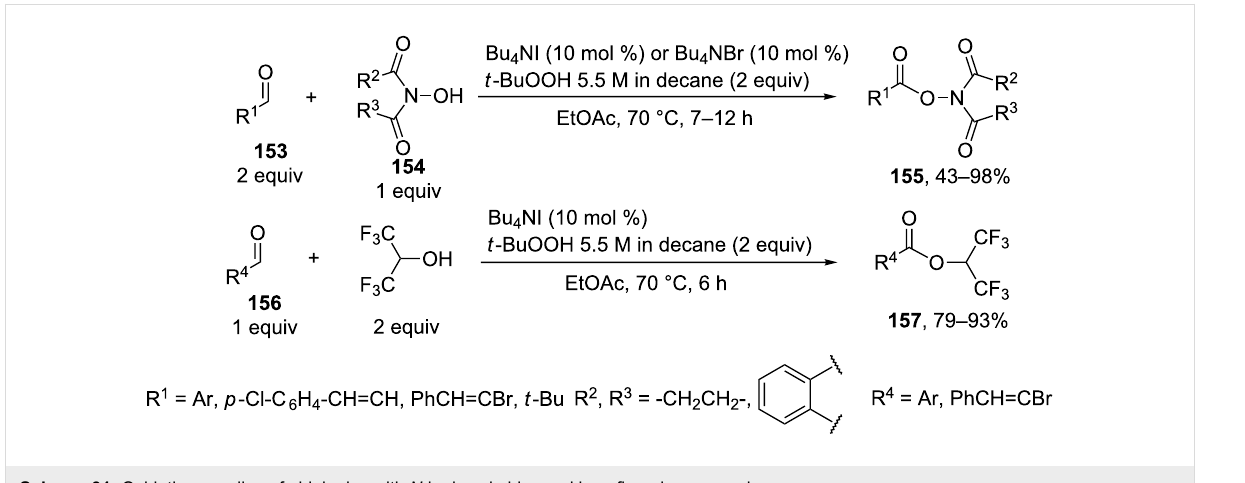
Scheme 31: Oxidative coupling of aldehydes with N -hydroxyimides and